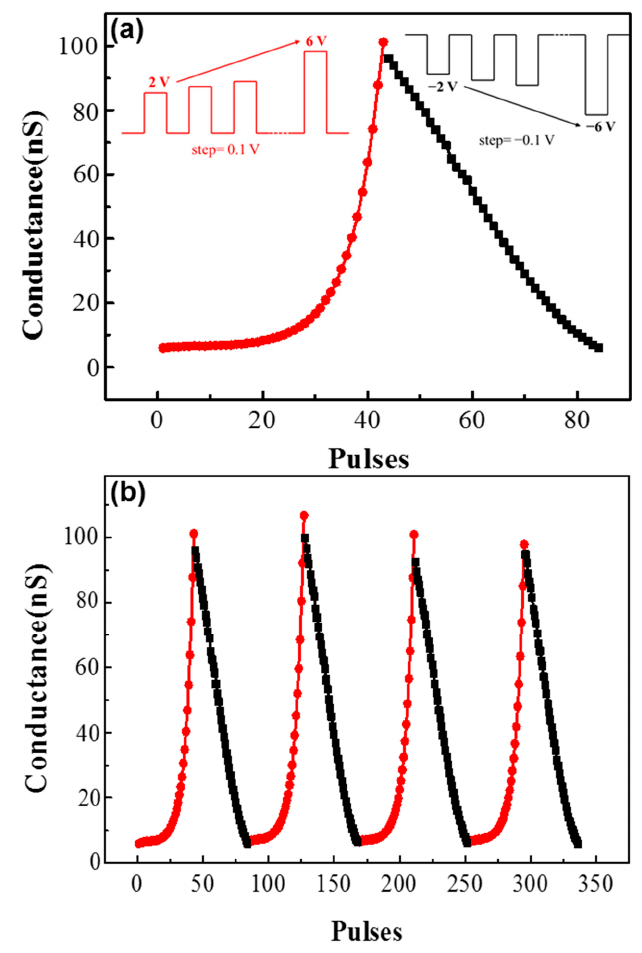
Figure 8. The measured long-term potentiation/depression synaptic function with non-identical training pulses: ( a ) the training pulses with increasing amplitudes (potentiation: from 2 to 6 V, 100 μ s; depression: from − 2 to − 6 V, 100 μ s); and ( b ) the weight updates, recorded in four training cycles.